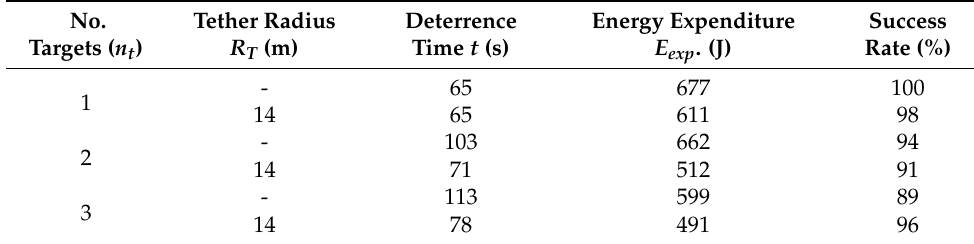
Table 4. Comparison between free-moving, ‘infinite’-tether benchmark case ( n = 1) with chosen tethered UAV strategy ( n = 4 ) . The free agent slightly outperformed in average energy expenditure elicited while the tethered team system had a better time performance metric. No. Tether Radius Deterrence Energy R T (m) Targets ( n t ) Time t (s)